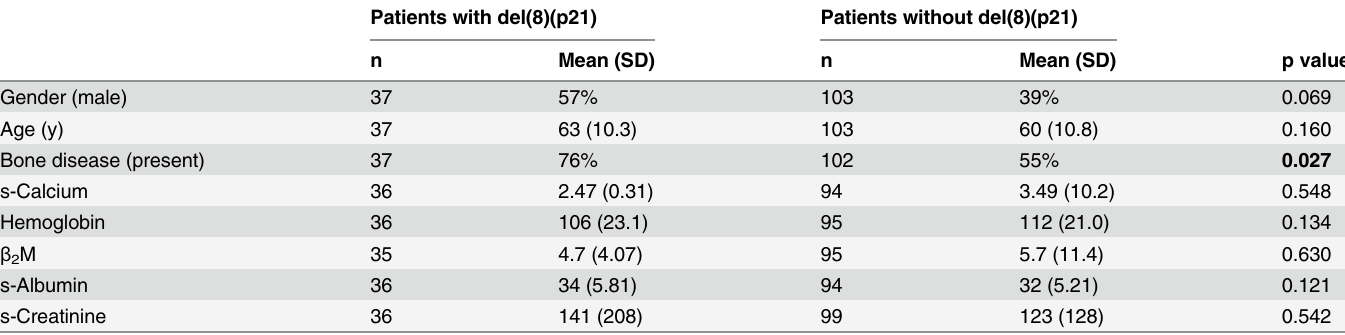
Table 1. Univariate analysis of clinical parameters of multiple myeloma patients. Patients with del(8)(p21) Patients without